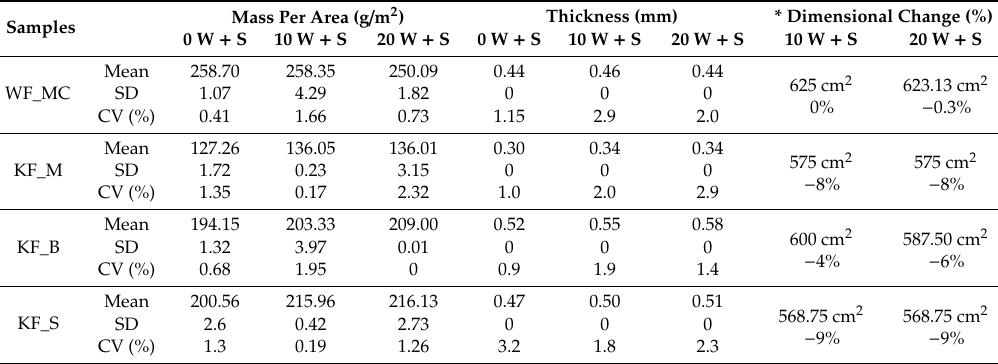
Table 3. Results of measuring construction